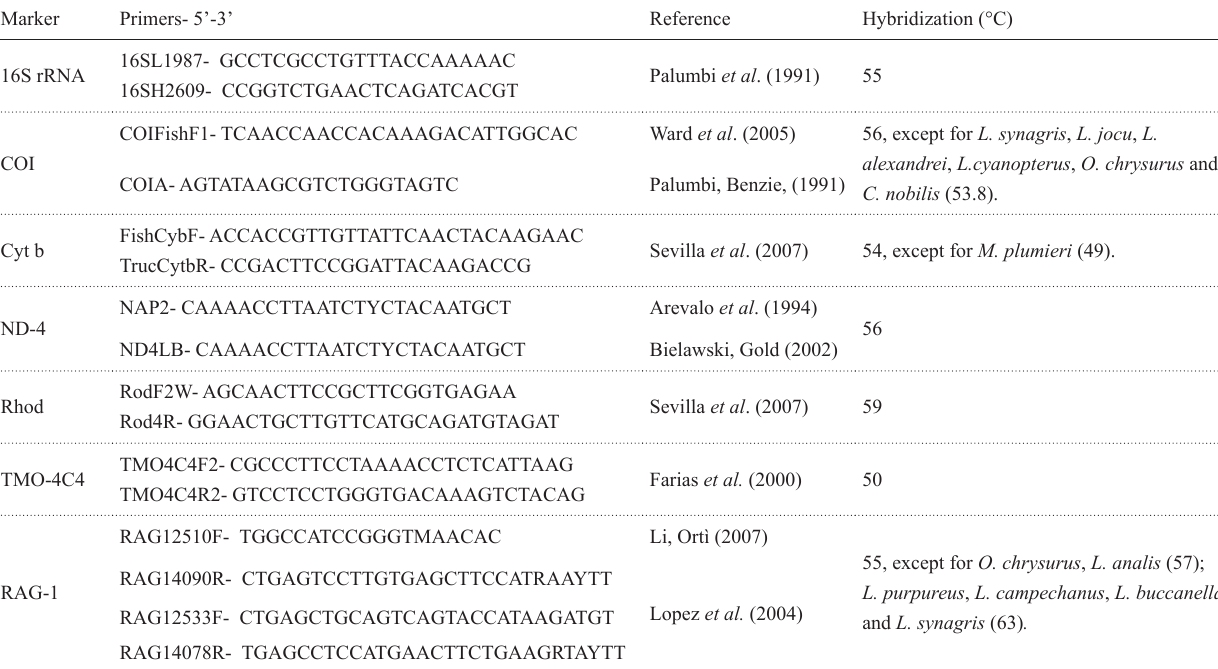
Tab. 2. Primers, references and hybridization temperature used for mitochondrial and nuclear